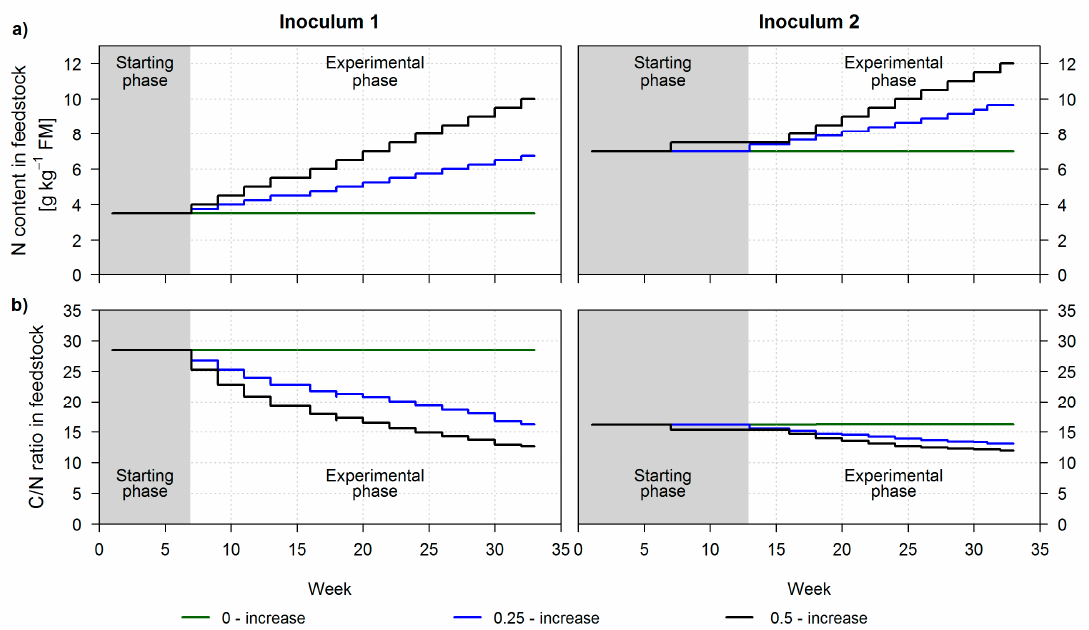
Figure 1. Experimental procedure: ( a ) N content in feedstock; ( b ) C/N ratio in feedstock. The results are given separately for inoculum #1 and inoculum #2. Different line colours in the graphs and in the legend correspond to the N-increase rates “0-increase”, “0.25-increase” and “0.5-increase” in the feeding regimes. Grey and white backgrounds in the graphs are related to the starting phase and the experimental phase, respectively.